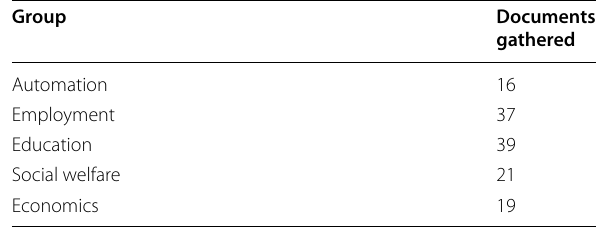
Table 1 General results for the Bibliometrics